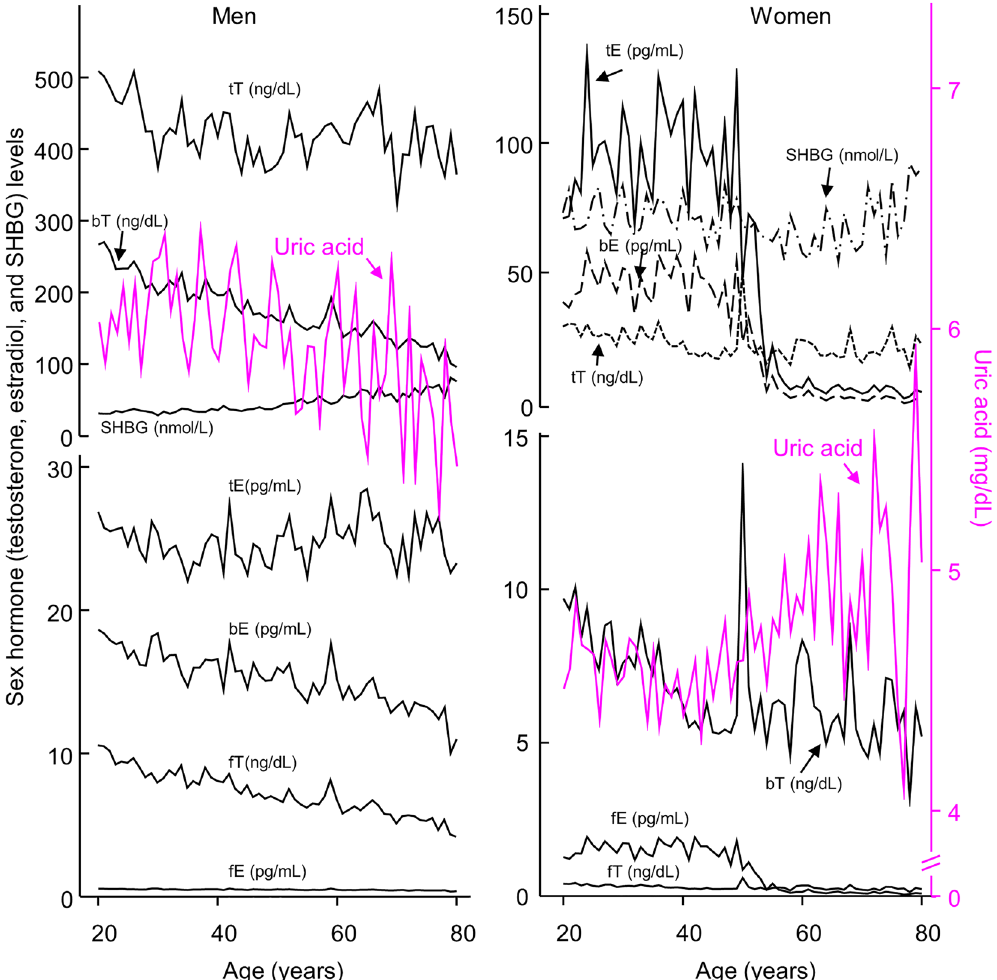
Figure 3. Serum levels of sex hormones and uric acid in adult men and women aged 20–80 years. Left panel, 4037 men which represented a weighted sample size of 88,248,186. Right panel, 3400 women which represented a weighted sample size of 70,353,795. bE bioavailable estradiol; bT bioavailable testosterone; fE free estradiol; fT free testosterone; SHBG, sex hormone-binding globulin; tE total estradiol; tT total testosterone. Data represent the weighted mean values over each year of